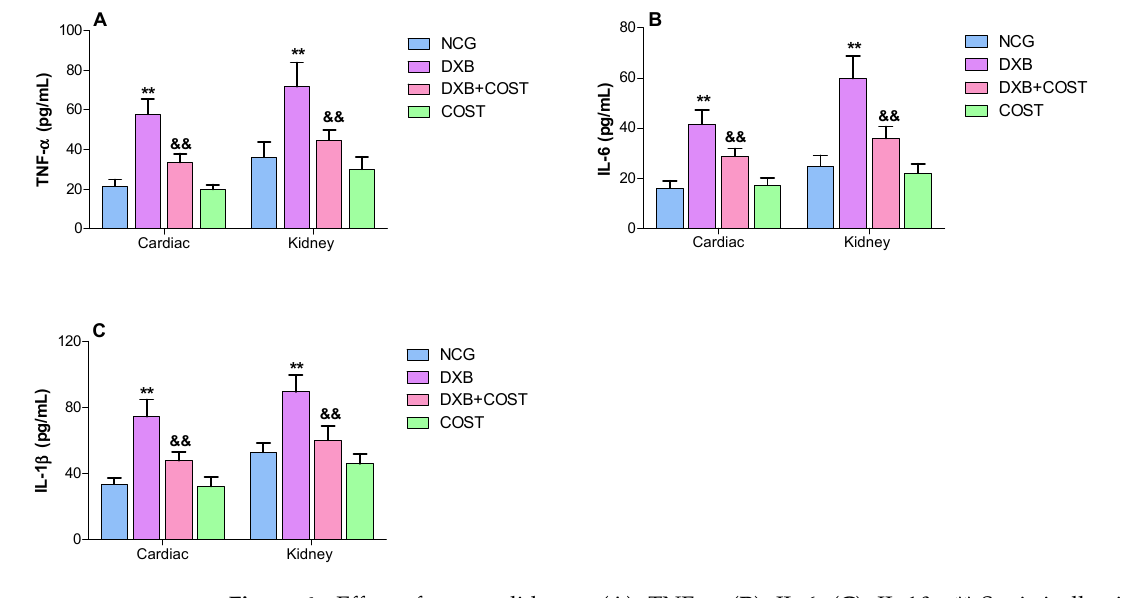
Figure 6. Effect of costunolide on: ( A ): TNF- α , ( B ): IL-6, ( C ): IL-1 β . ** Statistically significant ( p < 0.01) compared with NCG and COST groups. && Statistically significant ( p < 0.01) compared with DXB group.